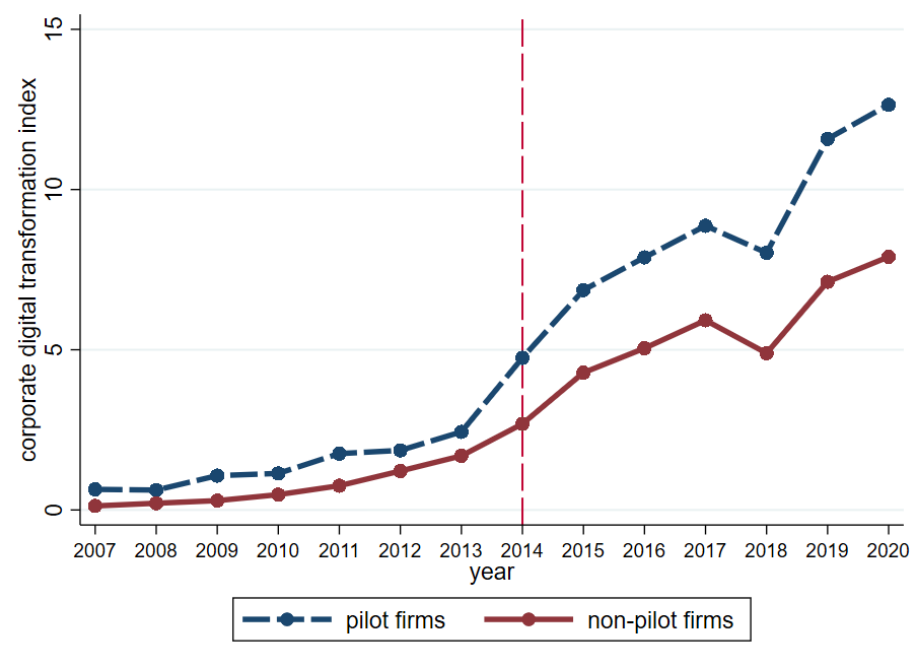
Figure 2. Digital transformation index of pilot firms and non-pilot firms. Table 3. Corporate digital transformation and green